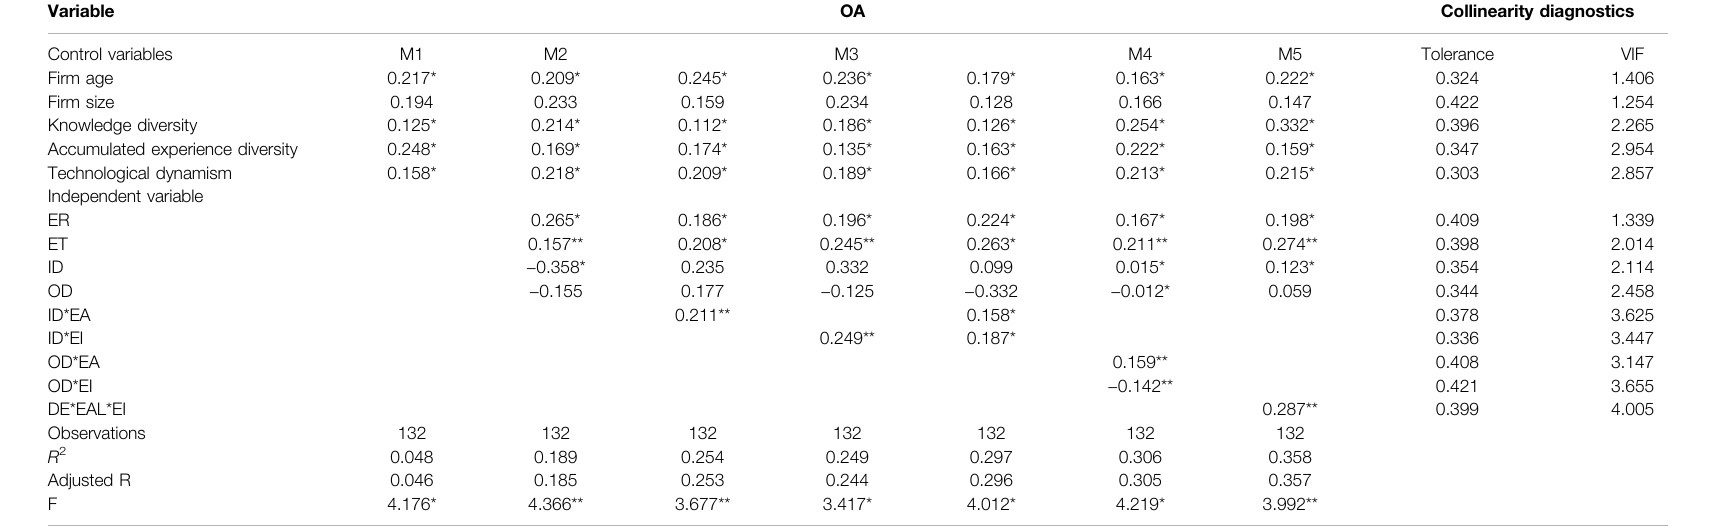
TABLE 4 | The regression analysis